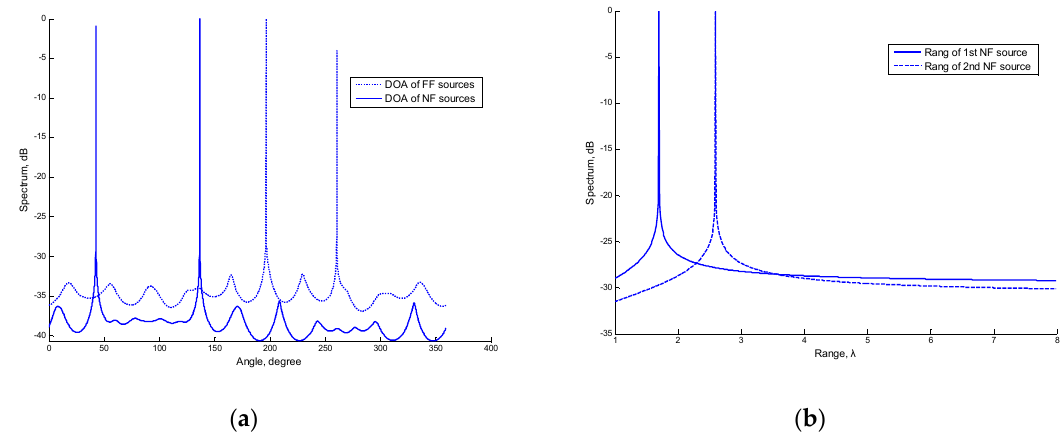
Figure 4. ( a ) Azimuth spectrum of proposed at ϕ= 65°; ( b ) Range spectrum of proposed.